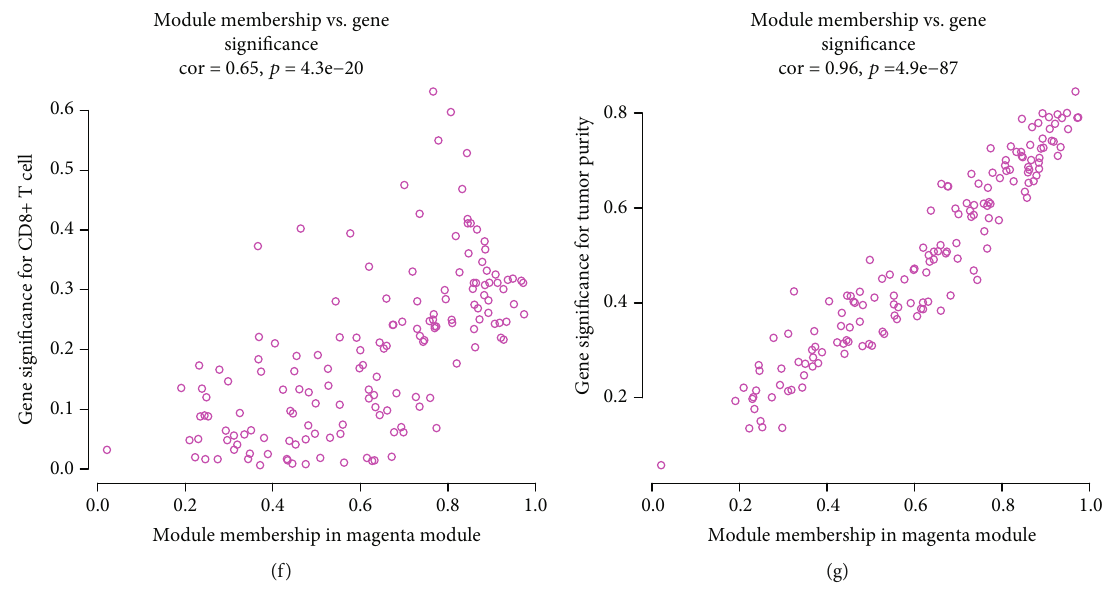
Figure 2: WGCNA. (a) TCGA-LIHC sample clustering results. (b) Twenty-two coexpression modules were conducted by WGCNA. (c) Correlation heat map among di ff erent coexpression modules and clinical phenotypes and CD8+ T levels. (d, e) The correlation of genes in grey60 modules with CD8+ T cells and tumor purity. (f, g) The correlation of genes in magenta modules with CD8+ T cells and tumor